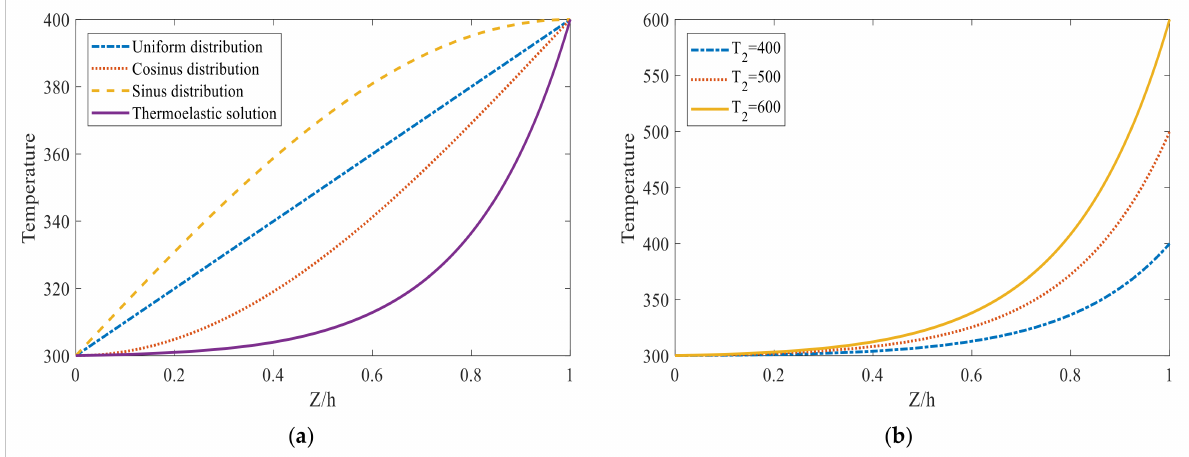
Figure 3. Different temperature distributions, when b = 10 h, a = b, Λ GPL = 0.3 ( wt% ) , GPL-X, T 1 = 300, T 2 = 400. ( a ) Representation of the effect of different distribution, ( b ) temperature variation for different temperature boundary